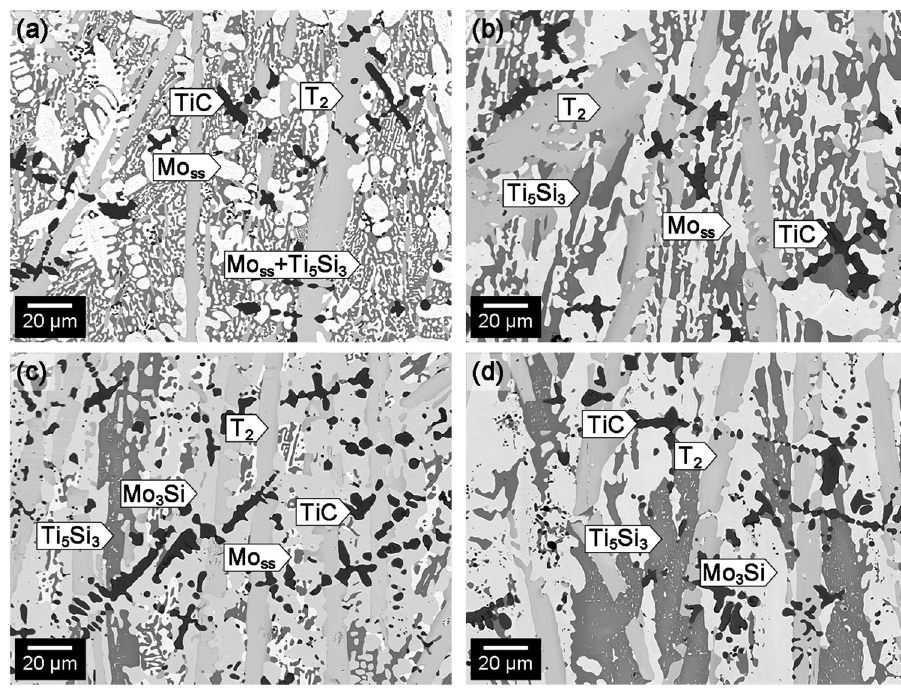
Figure 1: Microstructures of the heat - treated ( a ) base, ( b ) 10Cr, ( c ) 5Cr5Al and ( d ) 10Al